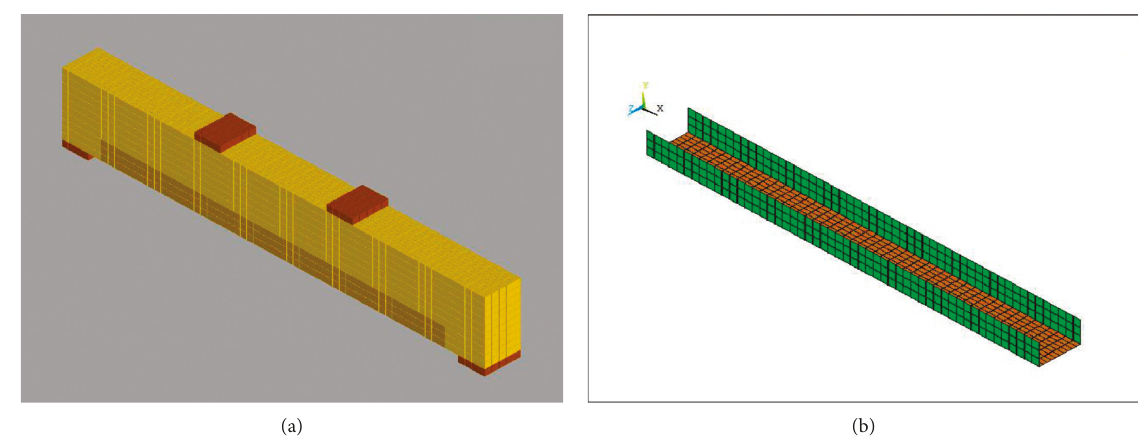
Figure 5: (a) Models B6 and B8 using the bottom wrapping technique and (b) the BFRP strips. Table 4: Comparison of experimental and current FE approach (the yield and maximum deflections). Deflection (mm) Loadings (experimental)- (experimental) Model mark